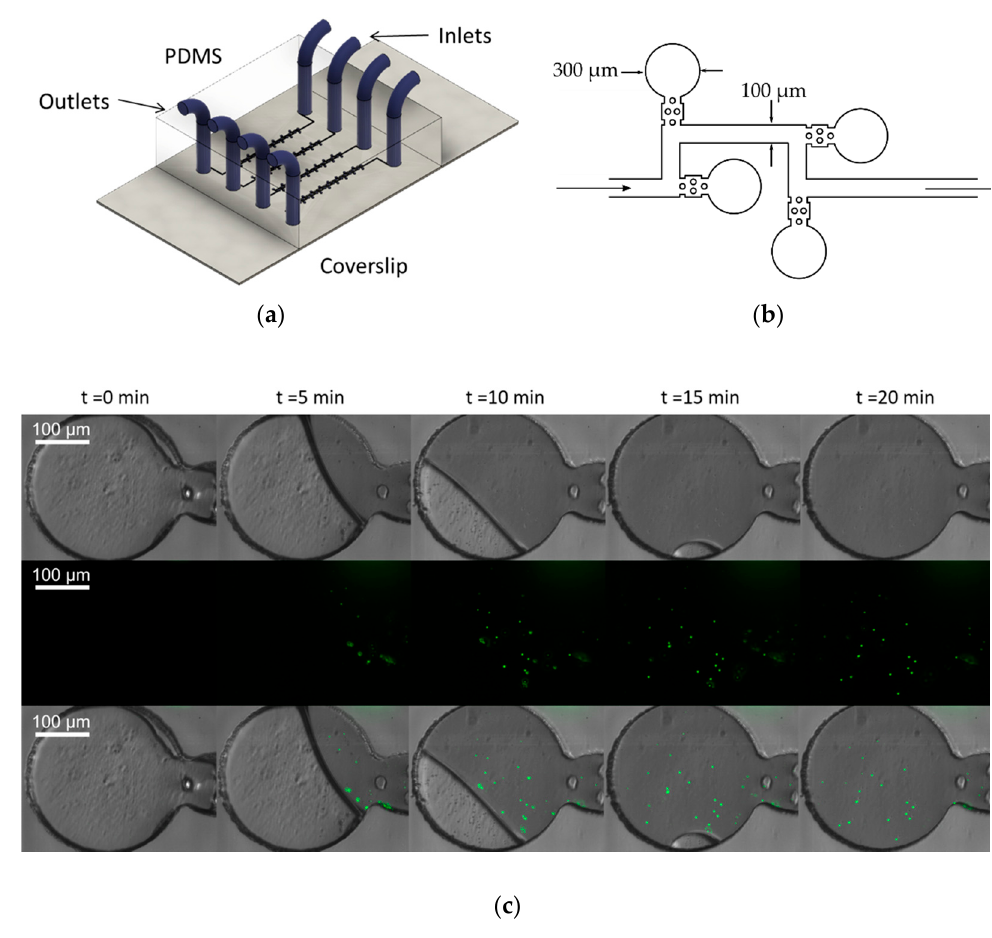
Figure 5. Time-lapse images of 1 μ m fluorescence beads entering microchambers using a Motic CCIS Plan achromatic phase contrast objective UC Ph2 20x objective; ( a ) schematics of the microfluidic device for time-lapse microscopy of fluorescent bacteria; ( b ) detail of the microfluidic channel design (adapted from [28]). The chambers are 300 μ m in diameter and the channels are 100 μ m wide. The height of all the channels is 35 μ m; (c) time-lapse images of 1 μ m microspheres loaded into the microdevice. (Top Row) Bright-field channel; (Second Row) fluorescence channel and (Bottom Row) an ImageJ composite of bright-field and fluorescence channels are shown.